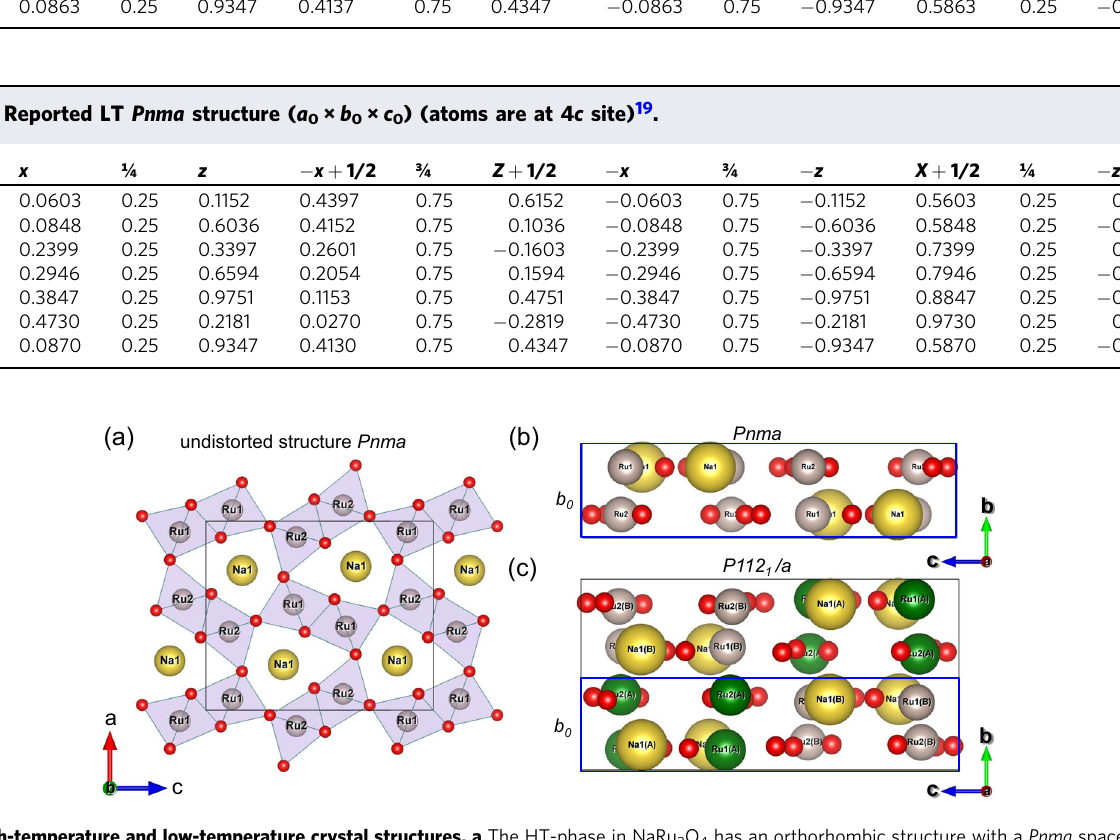
Fig. 4 High-temperature and low-temperature crystal structures. a The HT-phase in NaRu 2 O 4 has an orthorhombic structure with a Pnma space group, similar to the CaFe 2 O 4 -type structure 1 . The octahedra and Ru atoms are represented in light brown and O atoms in red color. b The HT-phase crystal structure ( Pnma ) of NaRu 2 O 4 in bc -plane. c The LT-phase crystal structure of NaRu 2 O 4 has monoclinic symmetry P112 1 /a